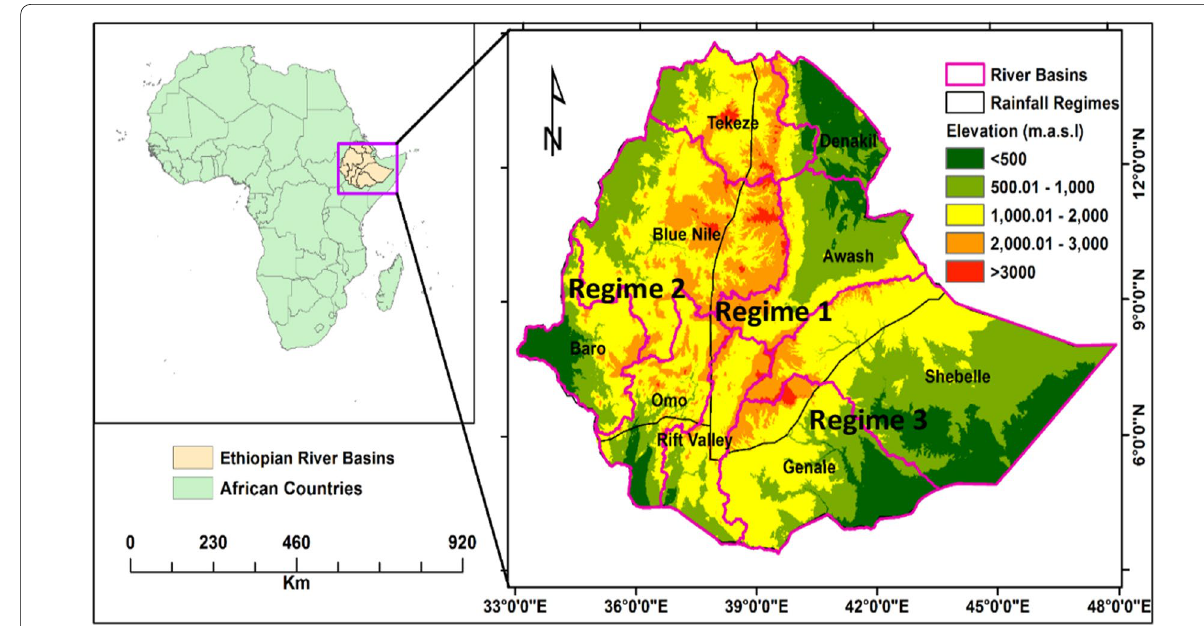
Fig.1 Location map of the study area showing African countries, Ethiopia and major river basins of